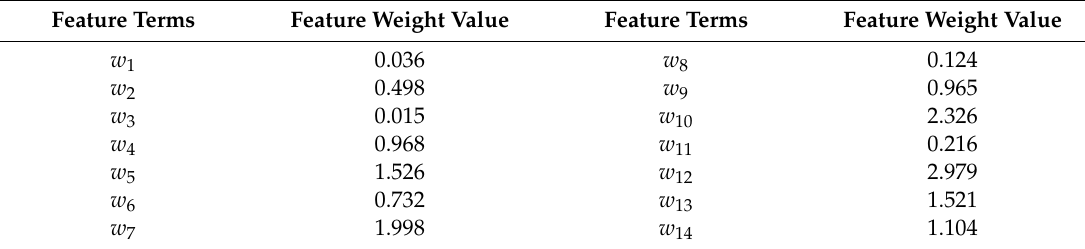
Table 2. Value of partial feature weights of surface